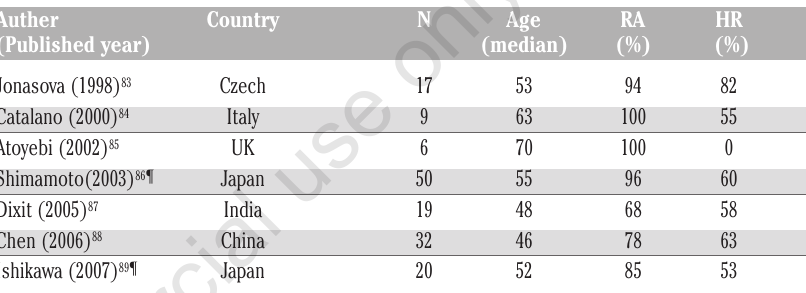
Table 4. Comparison of response to CsA